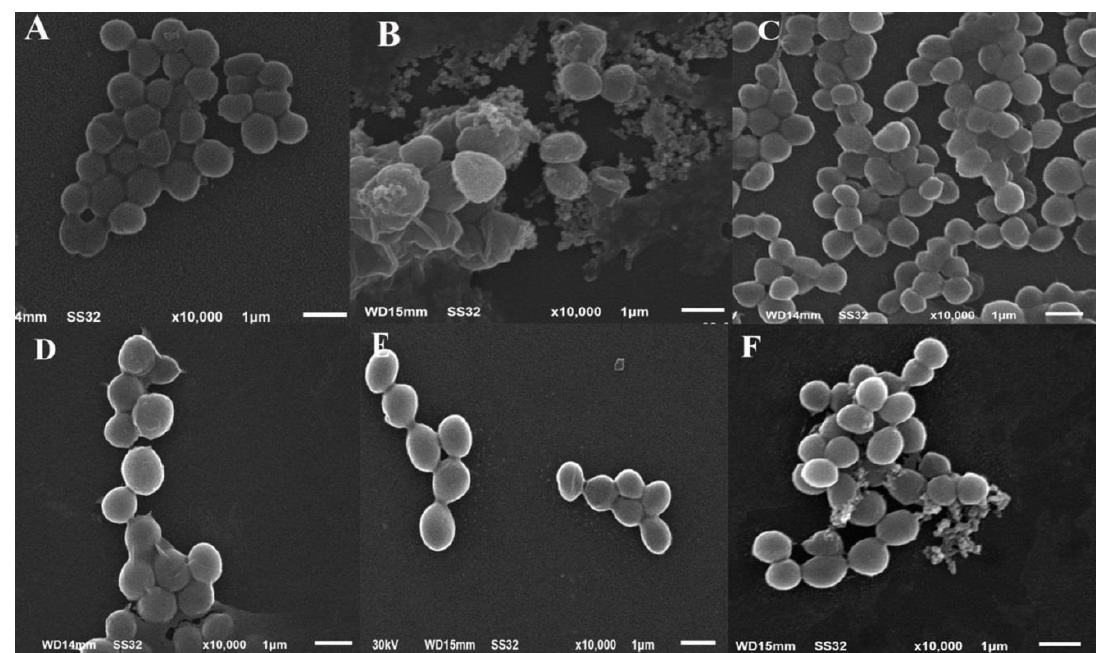
Figure 5. SEM micrographs of control S. aureus cells ( A ) S. aureus cells treated with MA-1156 ( B ), MA-1115 ( C ), MA-1116 ( D ), MA-1113 ( E ) and MA-1114 ( F ).